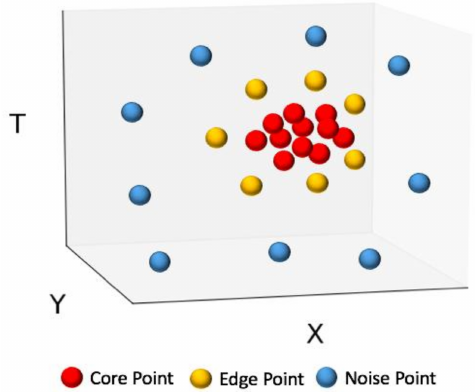
Figure 2. Spatial-temporal clustering by Spatial-Temporal Density-Based Spatial Clustering of Applications with Noise